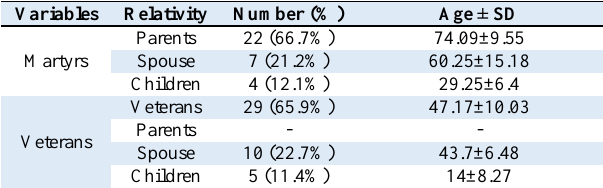
Table 1. Demographic information of the participants Variables